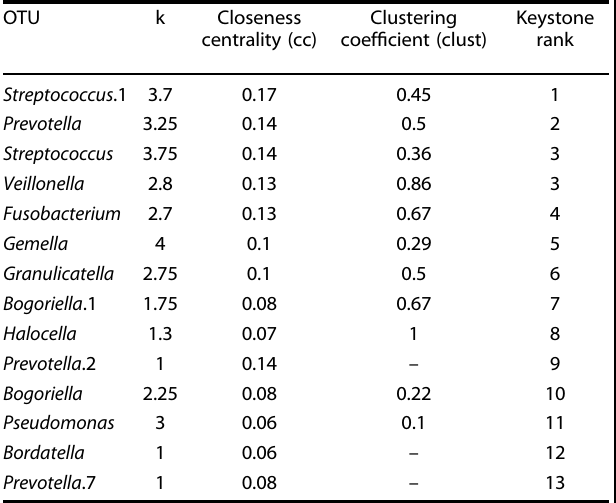
Table 1. Predicted keystoneness of OTUs in taxa co-occurrence NWs based on data by Zhao et al. 38